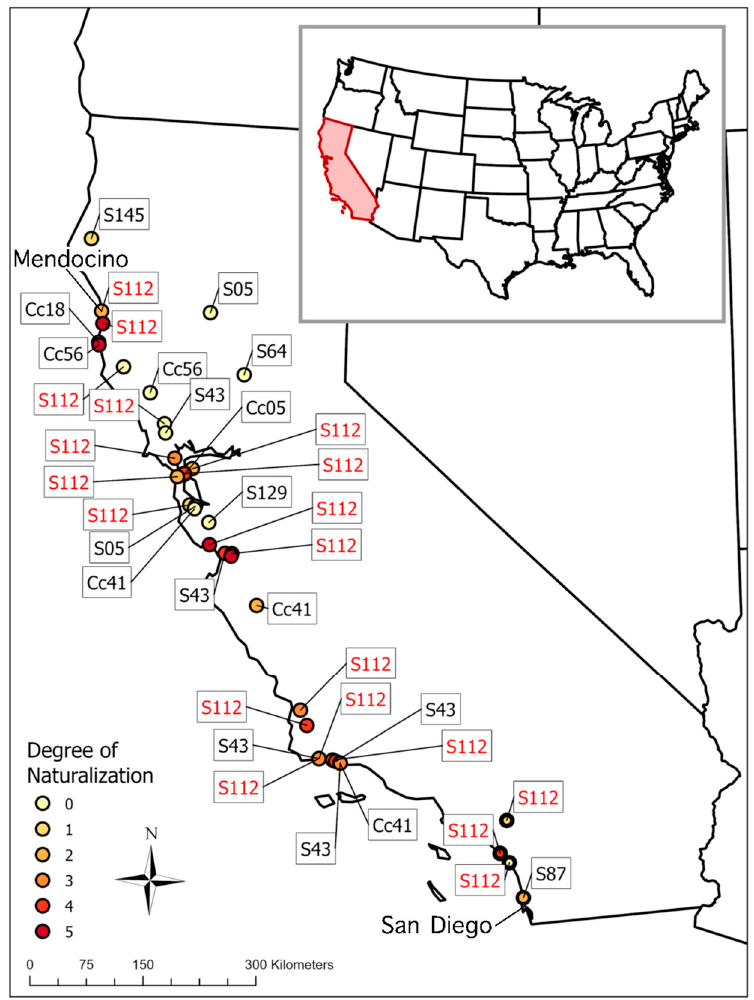
Figure 2. Collection locations, degree of naturalization and distribution of cpDNA J LA+ haplotypes in adult samples of Eucalyptus globulus from California (see Table S1 for further details). The J LA+ haplotypes have been grouped into Central (Cc) and Southern (S) types, and codes follow Table A1 and Table S1. The distribution of the S112 haplotype, which has only been found in ornamental plantings of E. globulus in Australia, is indicated in red. Only locations used in the naturalization study with J LA+ haplotypes available are plotted (detailed in Table S1).